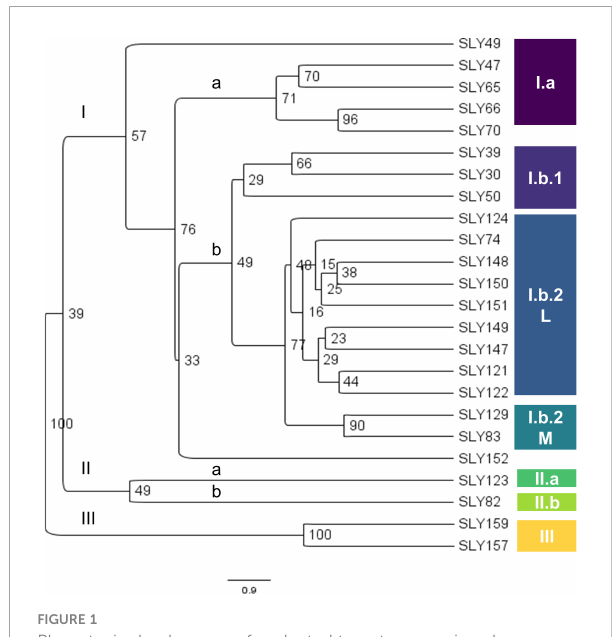
FIGURE 1 Phenotypic dendrogram of evaluated tomato accessions by Euclidean distance and the UPGMA grouping